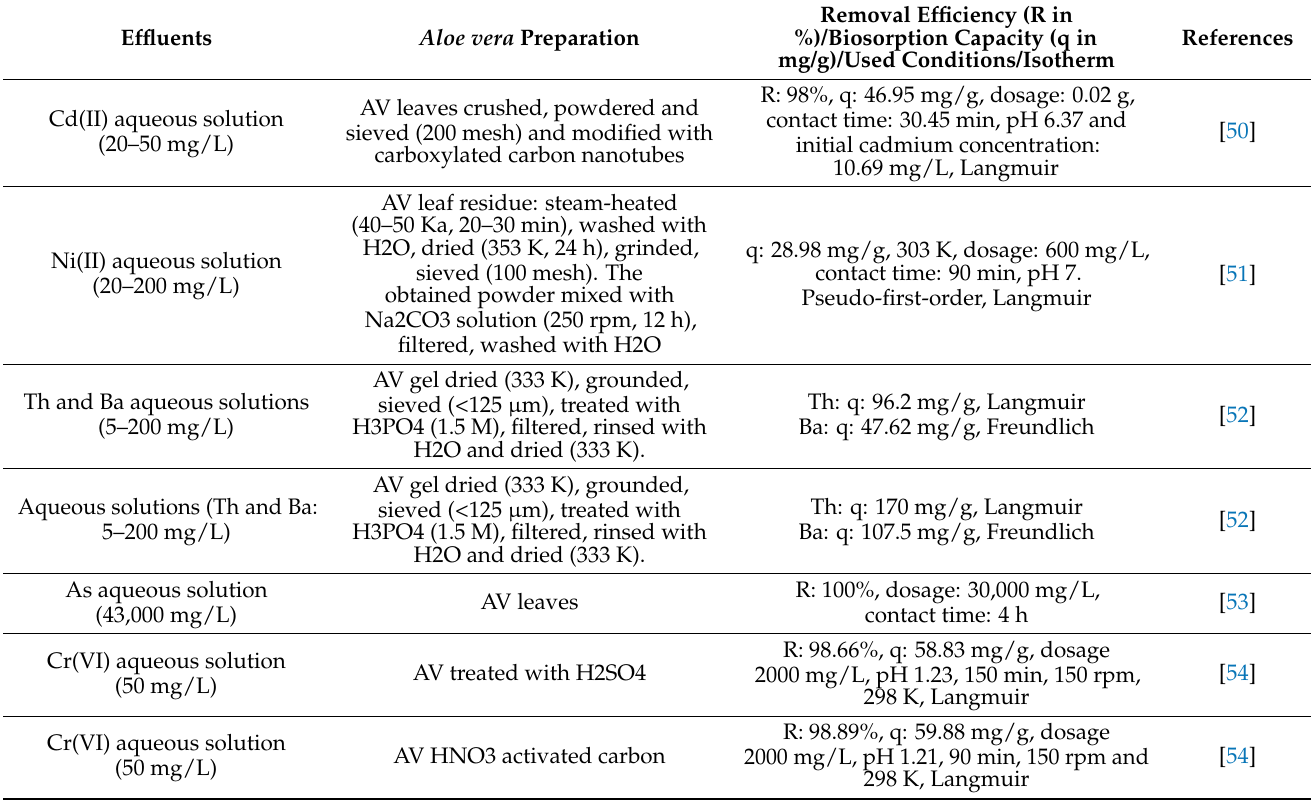
Table 2. Aloe vera as biosorbents for pollutants